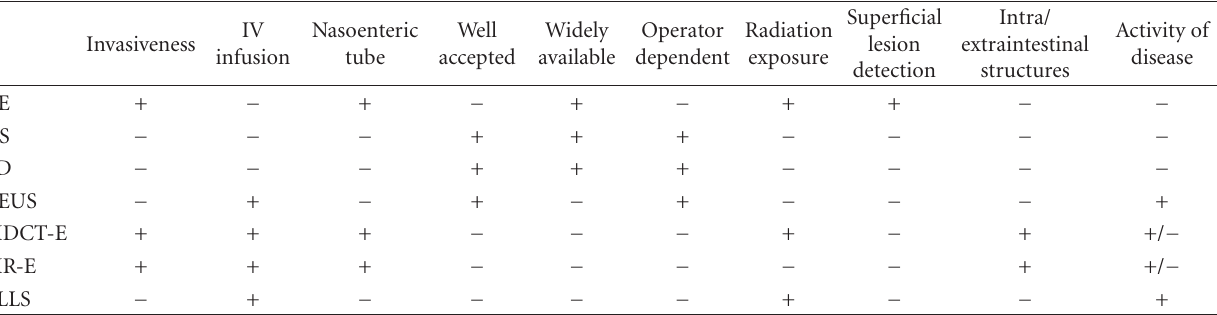
Table 1: Imaging techniques features in Crohn’s